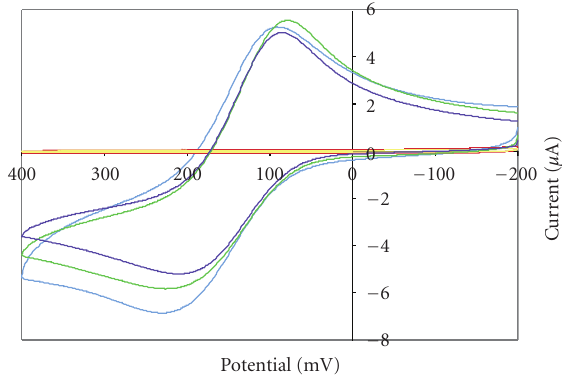
Figure 22: CV on gold (A), FTO (B), ITO (C), and osmium modified FTO (D) and ITO (E) working electrodes in the presence of ca. 0.1 mM Co(DTB) 3 ClO 4 . Potential referred to